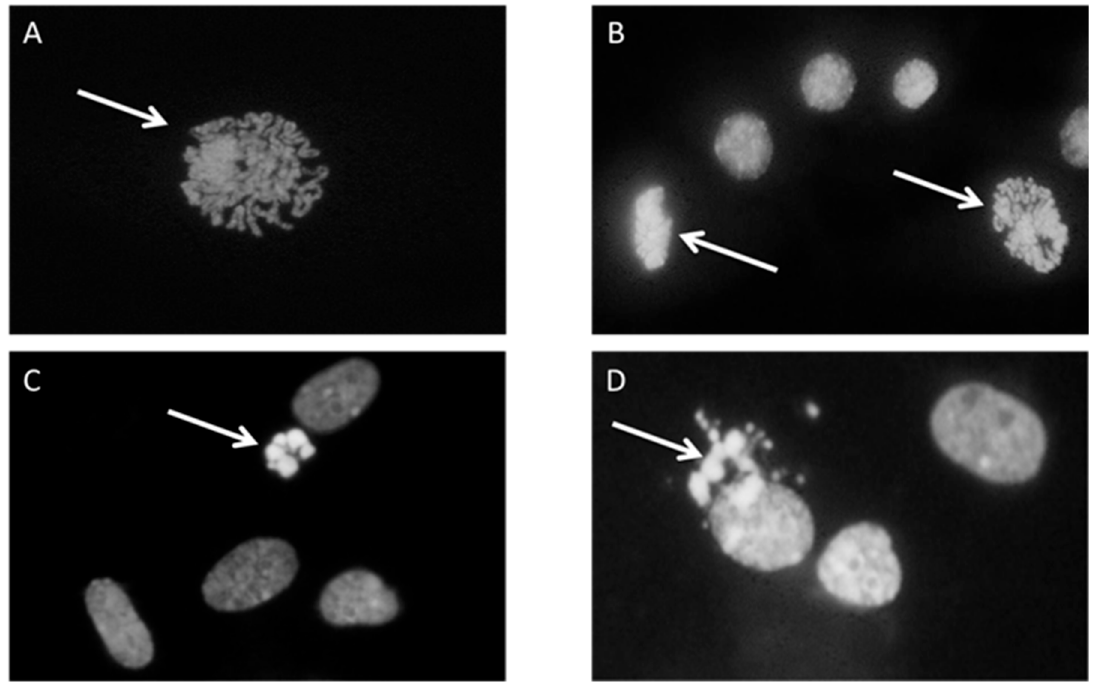
Figure 1. Cell proliferation and apoptosis, cells were stained with 4’,6-diamidino-2-phenylindole (DAPI) and pictures were taken under fluorescence microscope. Arrows represent the cell in the state of ( A ) Prophase; ( B ) prophase and metaphase; ( C ) early apoptosis; ( D ) late apoptosis.